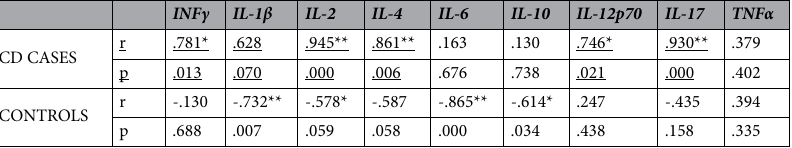
Table 4. Pearson’s correlation r between the total gluten ingested in the second year of life and the serum cytokine levels at 36 months in celiac disease (CD) cases and controls (CTRLs).